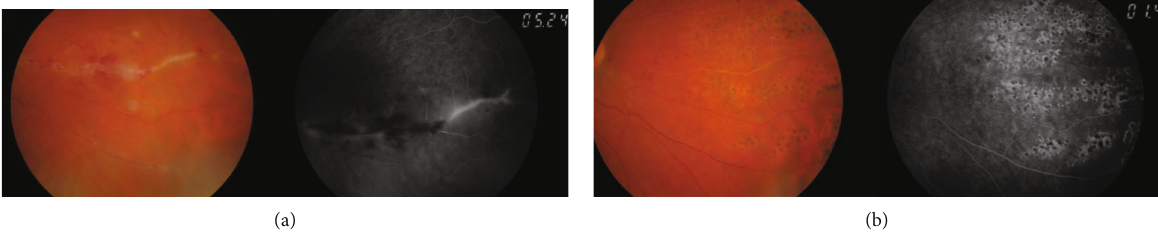
Figure 1: Retinography and fl uorescein angiography evidencing (a) active venous vasculitis with perivascular hemorrhages and retinal ischemia in the nasal quadrants OD in patient 1and (b) after medical treatment and scatter laser photocoagulation.